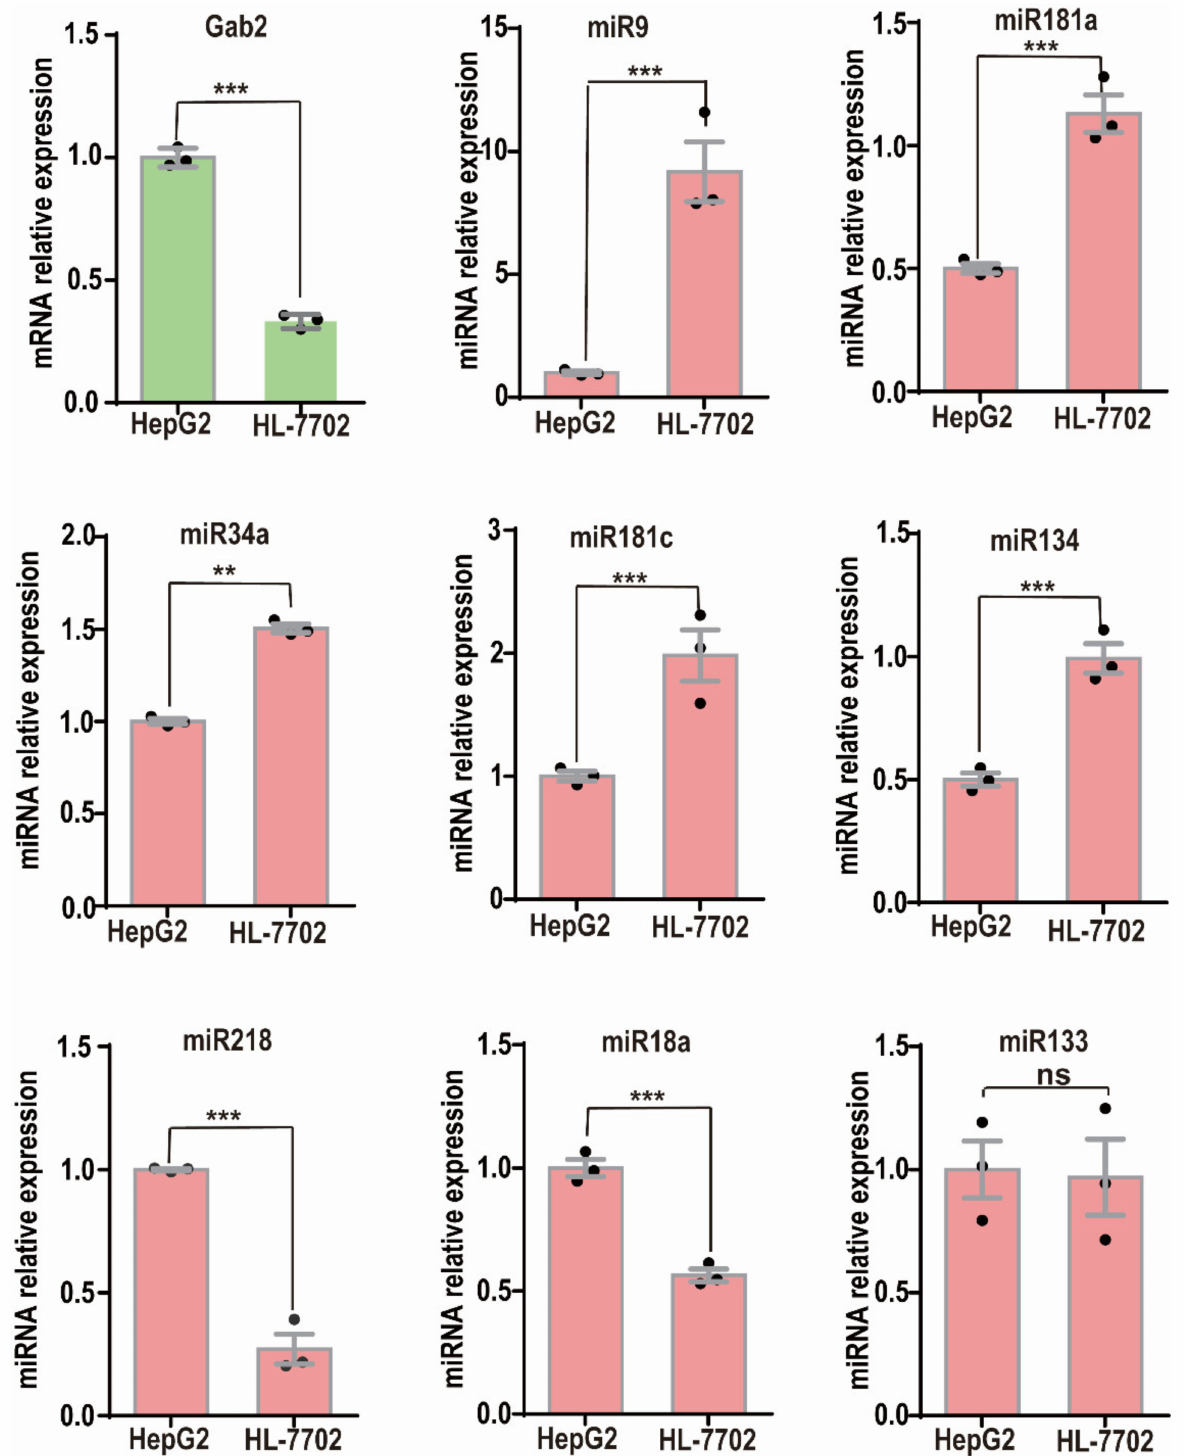
Figure 1. Expression of miRNAs in the hepatocellular carcinoma cell lines HepG2 and HL-7702. The results are presented as the means ± SDs. Statistical comparisons of values were made using Student’s t -test. ns, nonsignificant; ** p < 0.01, *** p <